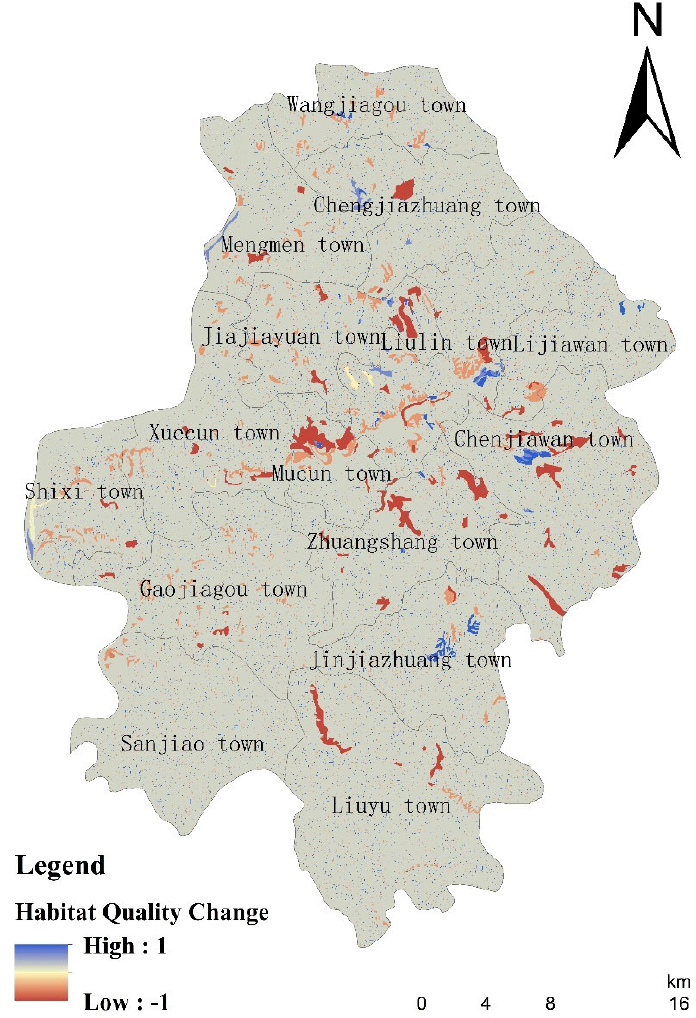
Figure 4. Spatial distribution of the changes of habitat quality from 2000 to 2020. In the figure, the value of 0–1 represents an increase in habitat quality, and the value of − 1–0 represents a decrease in habitat quality.